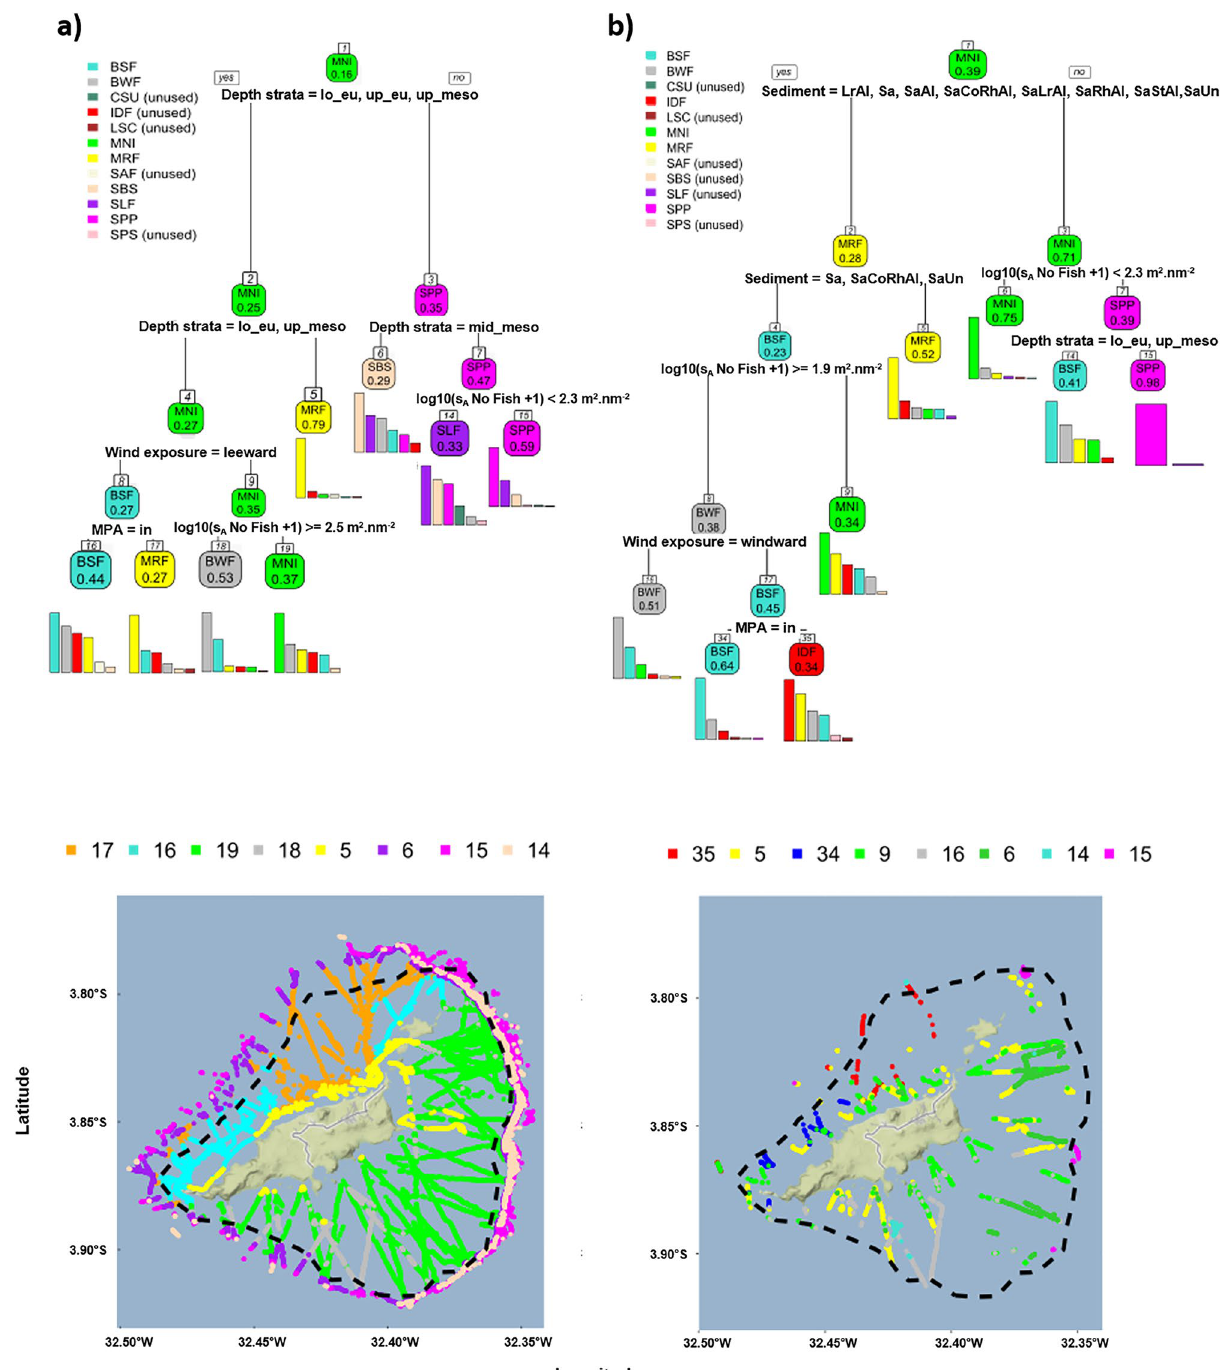
Figure 7. Regression tree ( a , b ) and associated prediction map ( c , d ) performed on the acoustic biomass (in log10(s A + 1)) of fish assemblages according to the environmental parameters with the complete data set ( a , c ) and the dataset limited to the locations with observed sediment ( b , d ). The fish assemblages identified at each terminal node are those with the highest proportion composition in percent. The composition in assemblage percent for each terminal node is represented by the histogram beneath it. Covariates used to develop the tree were depth strata ( up_eu upper euphotic, lo_eu lower euphotique, up_meso upper mesophotic, mid-meso mid-mesophotic, lo_meso lower mesophotic), position (wind exposure: windward or leeward), protection level (MPA: in or out) sediment (see Table 1 for sediments codes), fish-like and no-fish acoustic biomass (s A ). Fish assemblages abbreviations were, BSF bottom small fish, BWF: bottom weak detection, IDF: individual demersal fish, MNI: M. niger , MRF: mix reef fish, SBS: shelf-break school, SLF: shelf-break large fish, SPP: small pelagics and predators. Trees were made by the authors using diet package 107 . Maps were created by the authors using R (https:// www.R- proje ct. org/) and ggmap 113